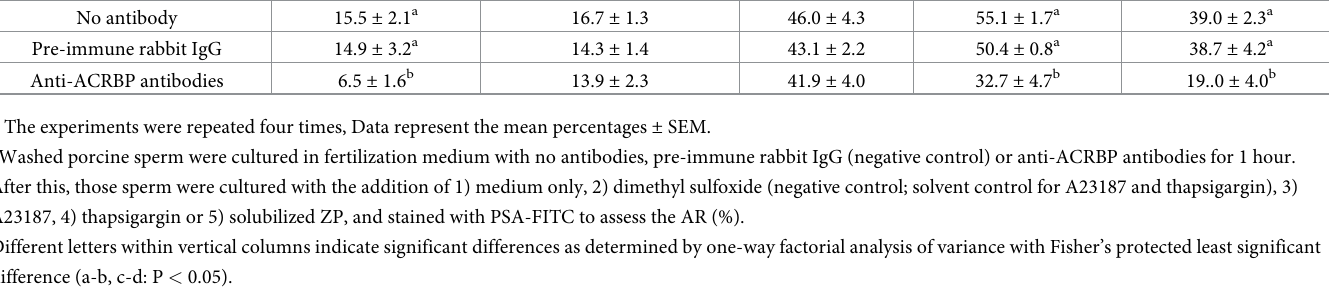
Table 5. Effect of anti-ACRBP on the AR induction of boar sperm by solubilized ZP # .